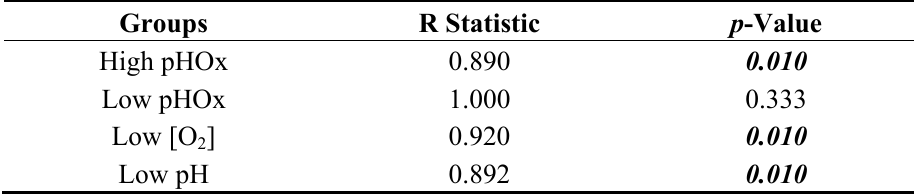
Table 3. Statolith elemental composition differences among capsules within each treatment were tested using a one-way analysis of similarities (Euclidean-distance matrix; elemental